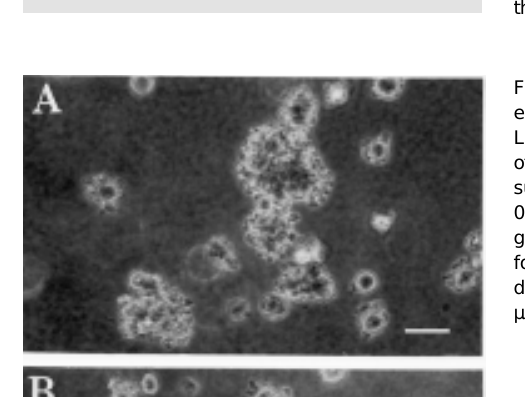
Figure 5. Migration of LISP-A10 and LISP-E11 cell clones towards laminin (LN) and fibronectin (FN) in comparison to 1% BSA (con- trol) immobilized on the outer surface of a modified Boyden chamber. Migration was ob- served after 16-h incubation at 37 o C. Experiments were per- formed in duplicate and analyzed by the Student t -test (*P = 0.03; **P = 0.007 and + P<0.001). The graph shows one representative experiment. Error bars indicate the standard